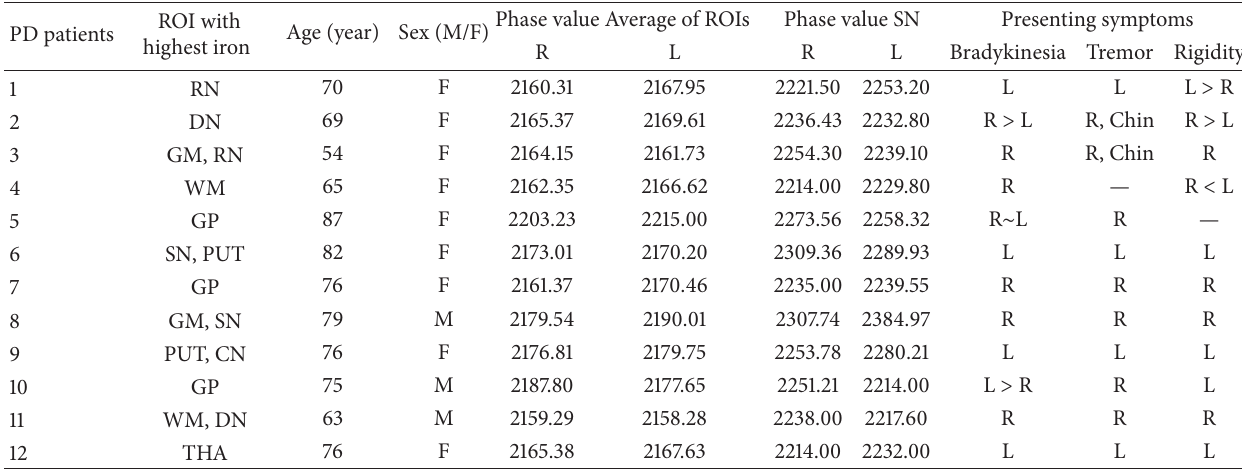
Table 3: Different ROIs with high phase values among PD